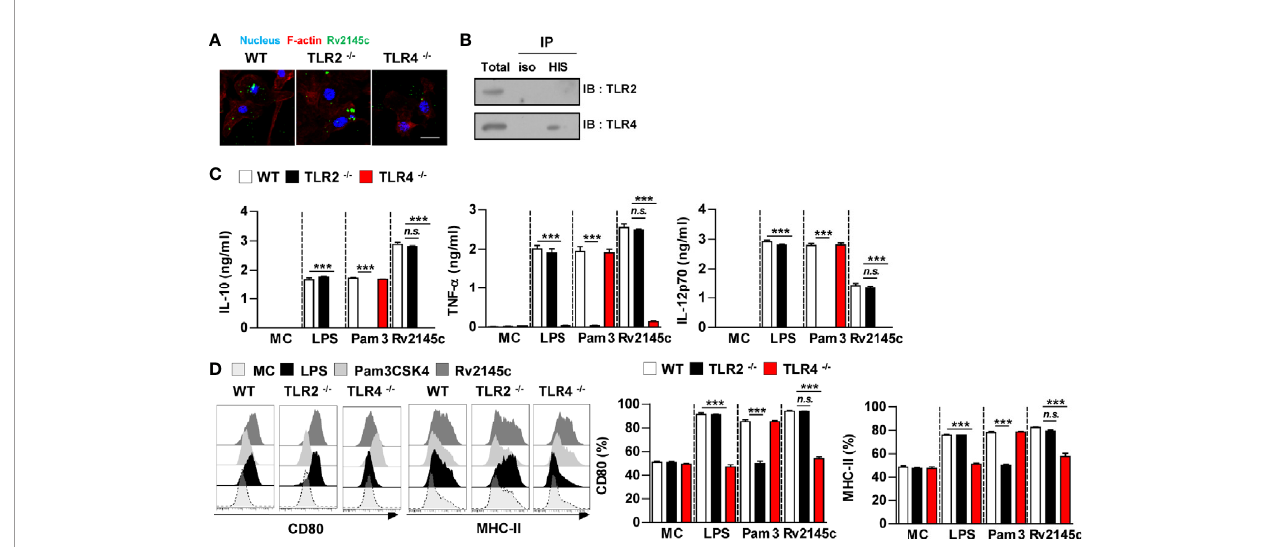
FIGURE 2 | Rv2145c induces macrophage activation via TLR4 pathways. BMDMs derived from wild-type (WT), TLR2 – / – , and TLR4 – / – mice were treated with Rv2145c (10 m g/ml), LPS (100 ng/ml), or Pam3CSK4 (Pam3) (100 ng/ml) for 24 h. (A) BMDMs-treated with Rv2145c for 1 h were fi xed and then stained with DAPI (blue) and an Alexa Fluor 488-conjugated anti-Rv2145c antibody. Representative images from three independent experiments are shown. Scale bar, 10 m m. (B) The lysates from BMDMs treated with Rv2145c for 6 h were used for immunoprecipitation with anti-mouse IgG or anti-His antibodies. Thereafter, proteins were detected using immunoblotting with anti-TLR2 or anti-TLR4 antibodies. The total is shown as the mean total in cell lysates (input). (C) The production of IL-10, TNF- a , and IL- 12p70 in the culture supernatants was determined by ELISA. All data are expressed as the mean ± SD ( n = 3). (D) Expression of CD80, and MHC class II molecules on BMDMs stimulated with each antigen was determined by staining and fl ow cytometry. The bar graphs show the mean percentage ± SD of each surface molecule on F4/80 + cells across three independent experiments. *** p < 0.001 for treatment values in BMDMs from TLR2 -/- or TLR4 -/- mice compared with those in Rv2145c-, LPS- or Pam3CSK4-treated BMDMs from WT mice. n.s., no signi fi cant difference. MC, medium